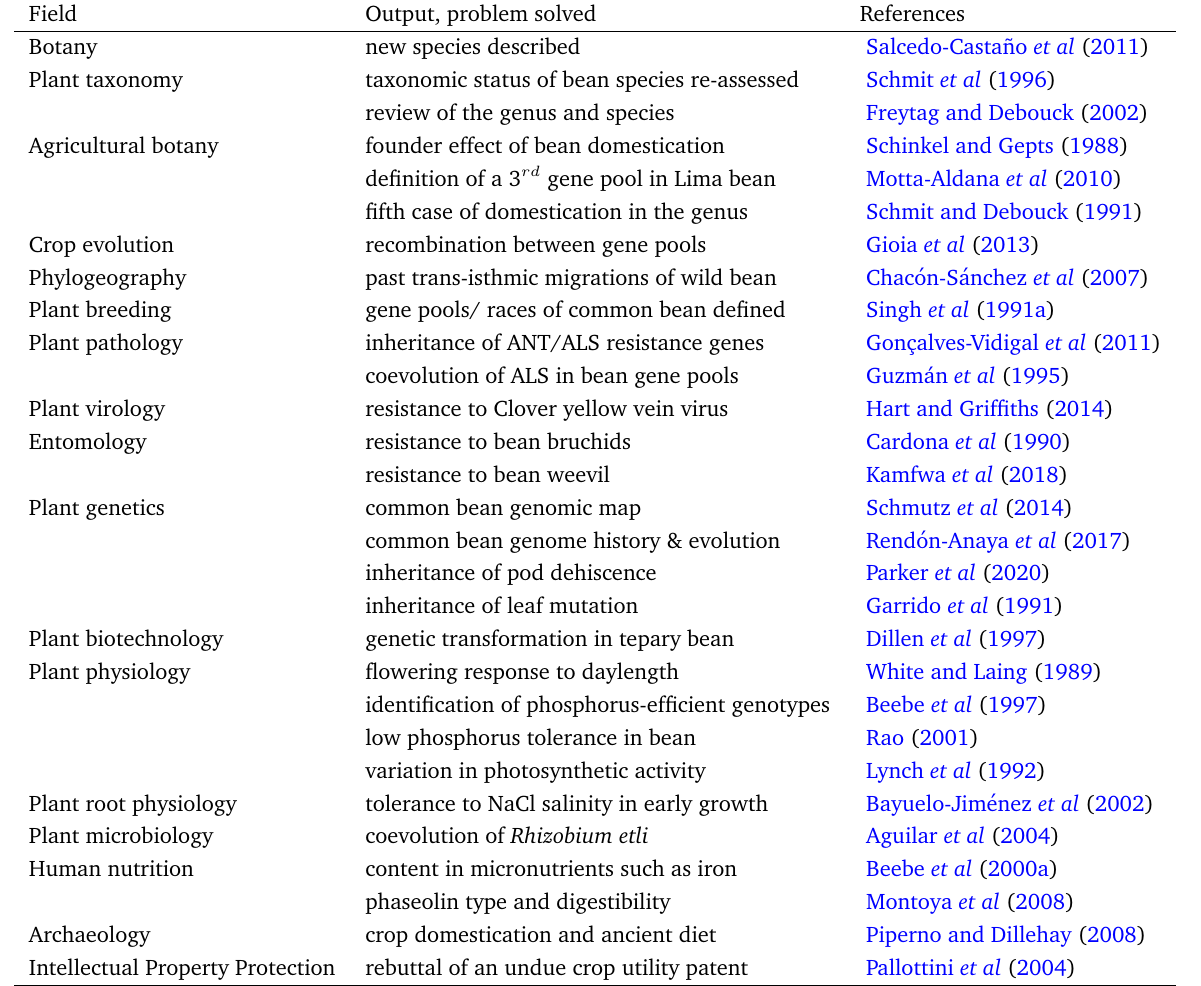
Table 3. Examples of impact of CIAT bean in-trust collection for the advance of